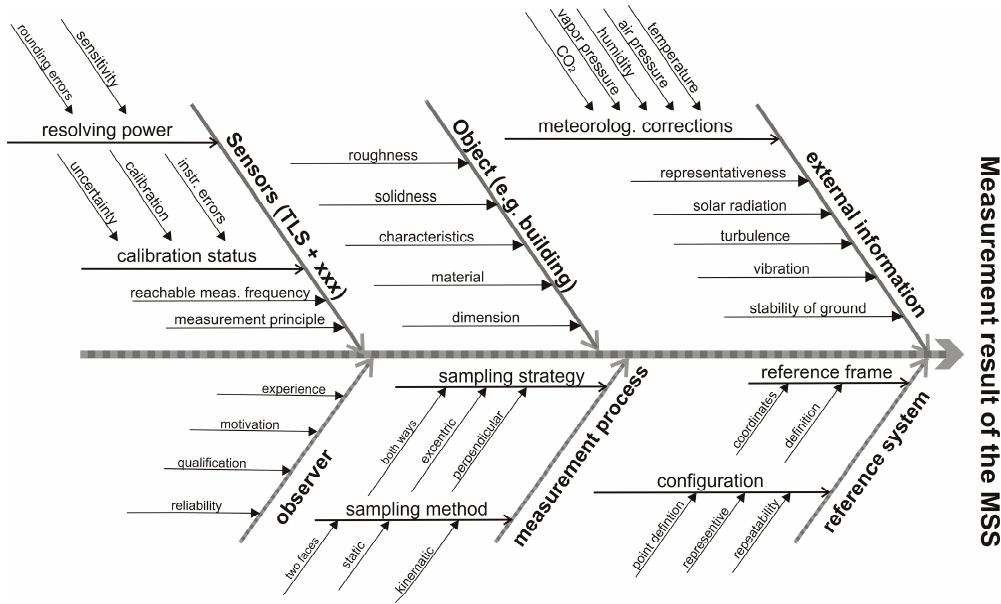
Figure 1. Influences on the measurements with Terrestrial laser scanning (TLS) and TLS-based multi- sensor-system (MSS). Modified from